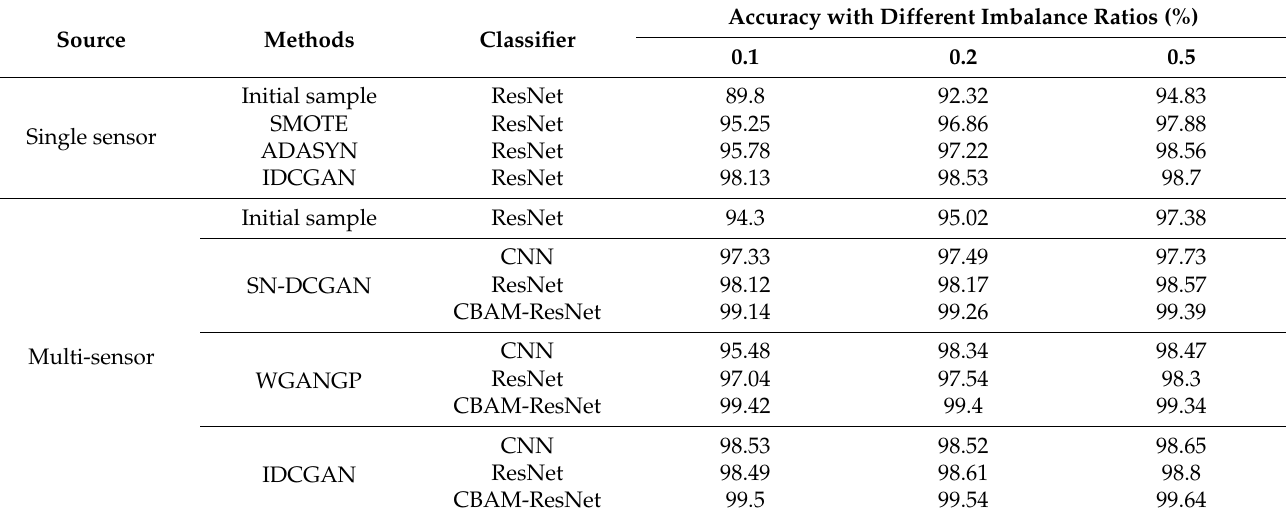
Table 2. Results after data augmentation of ORF with different initial imbalance